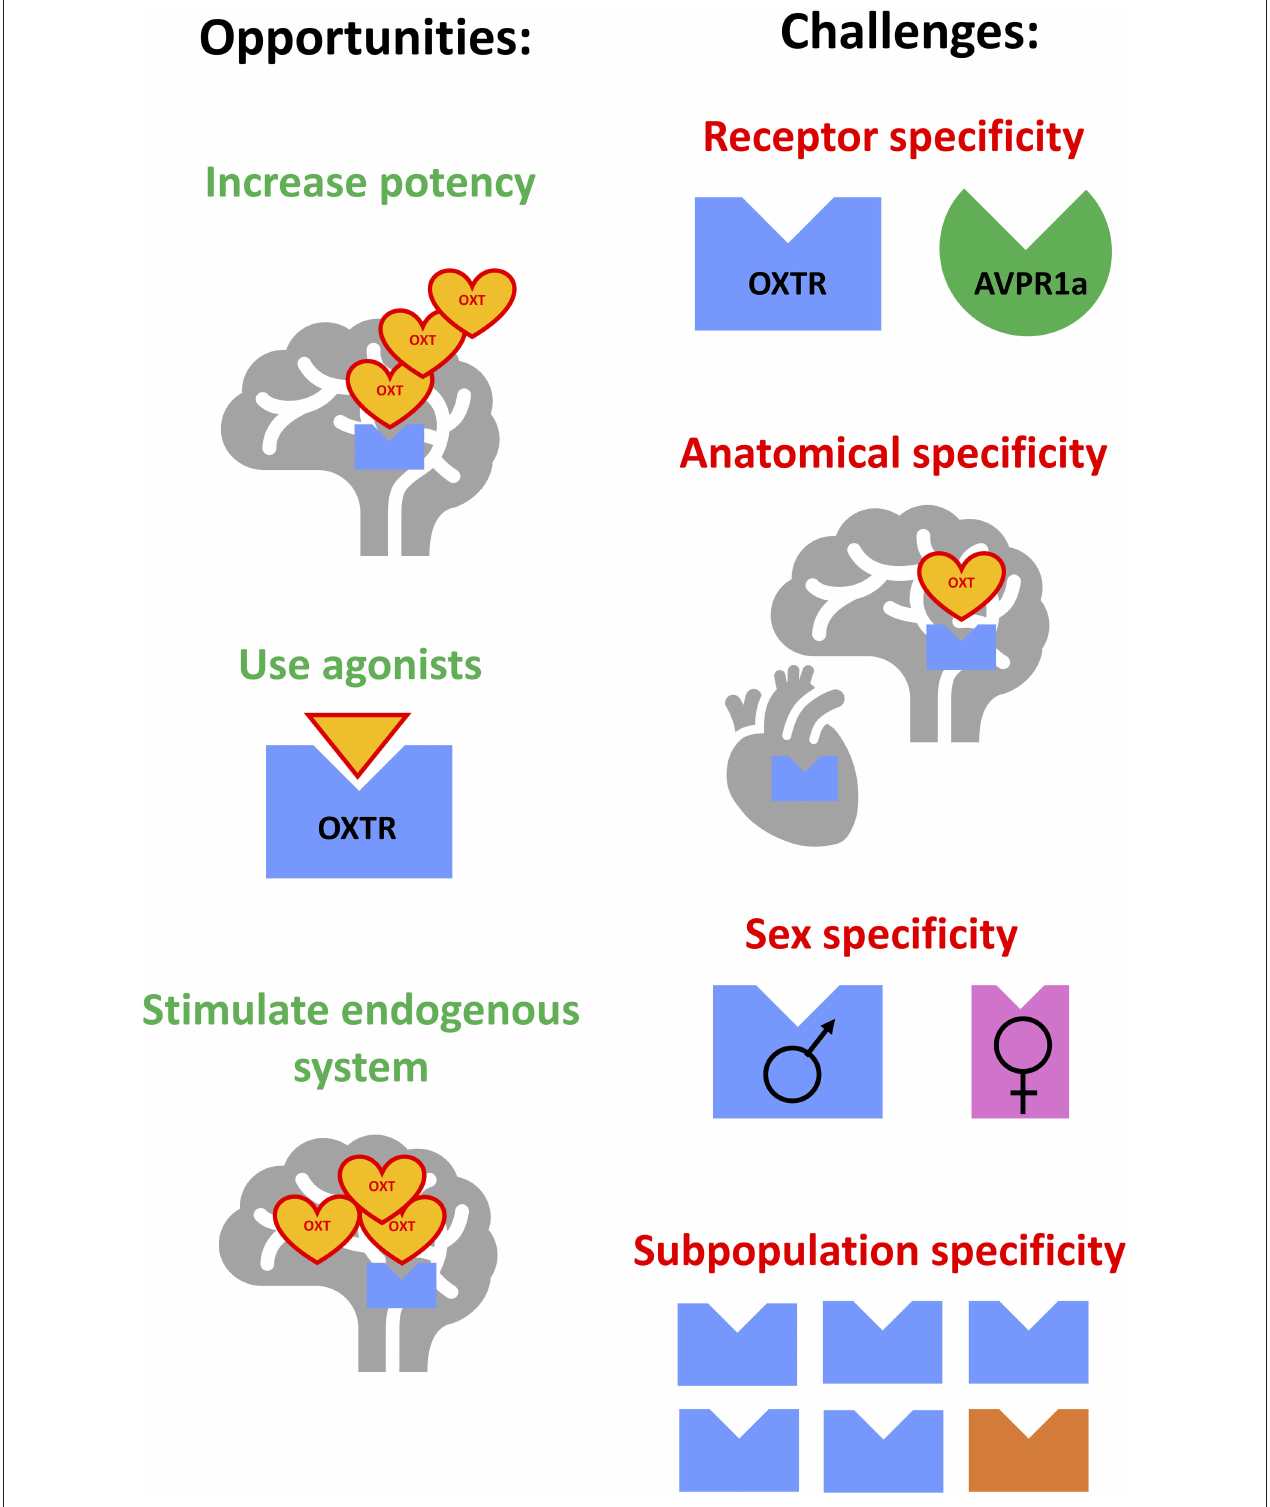
FIGURE 1 | Opportunities and challenges for improving the targeting of the oxytocin system for the treatment of alcohol use disorder. Opportunities: (1) increasing potency of exogenously-administered oxytocin, (2) development and use of oxytocin receptor agonists, (3) stimulating components of the endogenous oxytocin system. Challenges: (1) achieving specificity to oxytocin receptor vs. other related receptors, (2) achieving anatomical specificity (central vs. peripheral, or targeting specific subpopulations of neurons), (3) overcoming or focusing on potential sex-dependent effects, (4) identifying subpopulations sensitive to treatments due to genetic or environment-induced